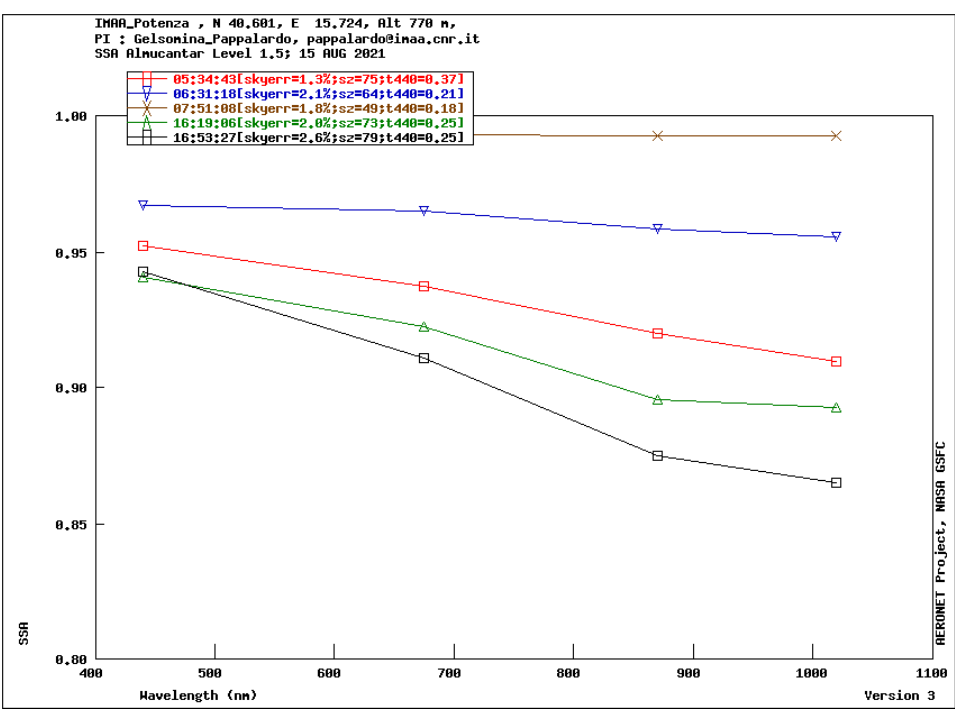
Figure 8. Spectral SSA provided by AERONET at 05:34, 06:31, 07:51, 16:19, and 16:53 UTC on 15 August 2021 at wavelength of 440, 675, 870, and 1020 nm.